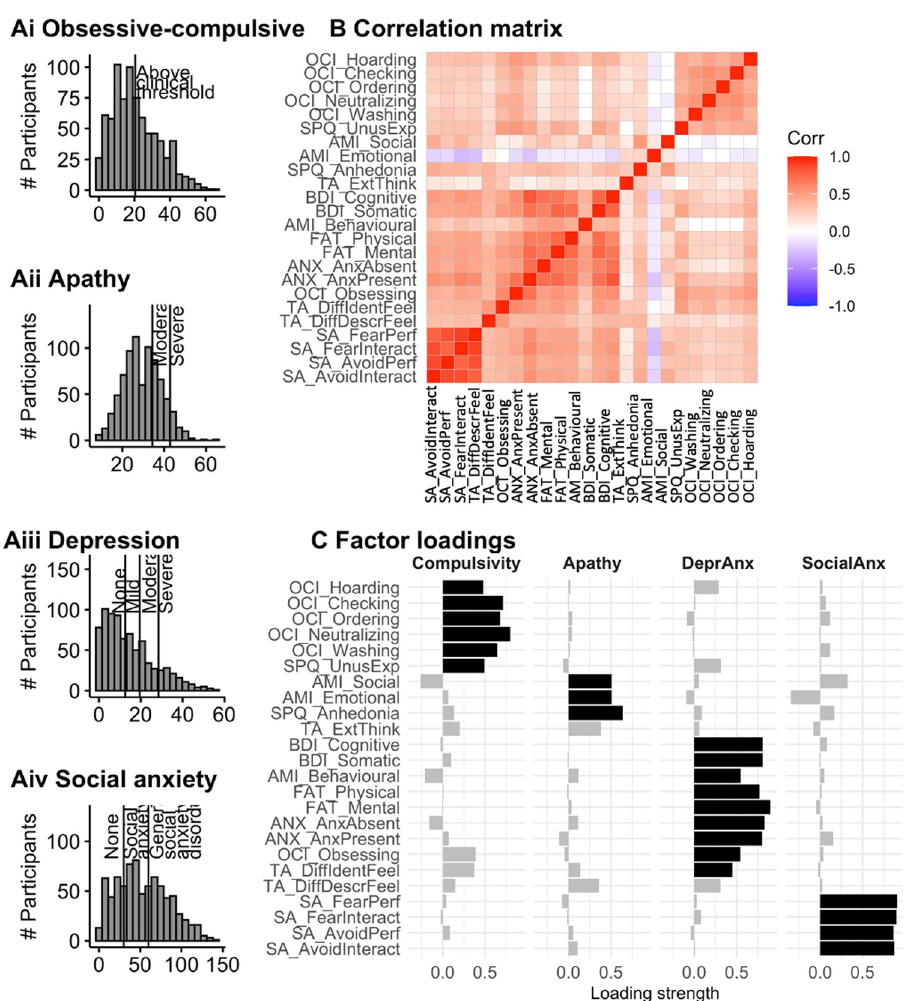
Fig 3. Psychiatric symptom questionnaires in the confirmation sample. (A) Histograms of the distribution of total questionnaire scores for the OCI-R (Ai), the AMI (Aii), the BDI (Aiii), and the Liebowitz social anxiety scale (Aiv). On each histogram, cutoffs based on previously published normative data are highlighted. (B) Correlation matrix (Pearson’s r) for all subscales included in the factor analysis. Squares highlight the factors subscales were assigned to in the factor analysis. (C) Factor loadings (i.e., the contribution of each subscale to each factor) of the factor analysis of the subscales. Highlighted in black are loadings above 0.4, for ease of visualisation. Data in panel A are available in S5 Data, panel B in S3 Data, and panel C in S16 Data. AMI, Apathy Motivation Index; BDI, Beck Depression Inventory; OCI-R, Obsessive-Compulsive Inventory.